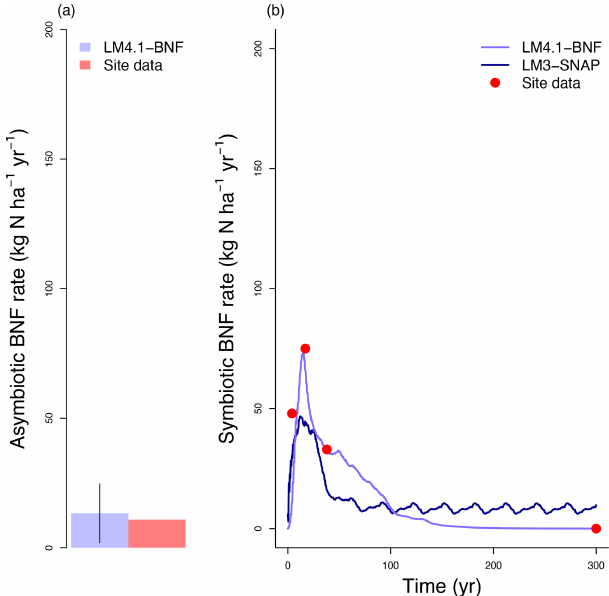
Figure 3. Simulated BNF rate by LM4.1-BNF and LM3-SNAP. (a) Simulated asymbiotic BNF rate compared to CHL site data. Sim- ulated data are averaged over the last 100 years of the 300 years of simulation to reflect the site data which are from mature forests. Error bars indicate 2 standard deviations. (b) Simulated symbiotic BNF rate over time compared to CHL site data for a 4, 17, and 38 years and mature forest (plotted at 300